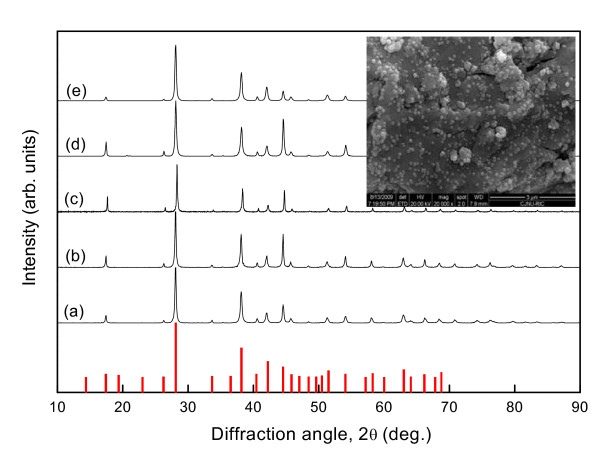
XRD patterns of Cu-dispersed Bi0.5Sb1.5Te3. (a) Bi0.5Sb1.5Te3 (BAT), (b) BAT + 0.05 wt.% Cu(OAc)2, (c) BAT + 0.1 wt.% Cu(OAc)2, (d) BAT + 0.3 wt.% Cu(OAc)2, and (e) BAT + 0.5 wt.% Cu(OAc)2. The inset is a SEM image of Cu-dispersed Bi0.5Sb1.5Te3 prepared by Cu(OAc)2 decomposition.